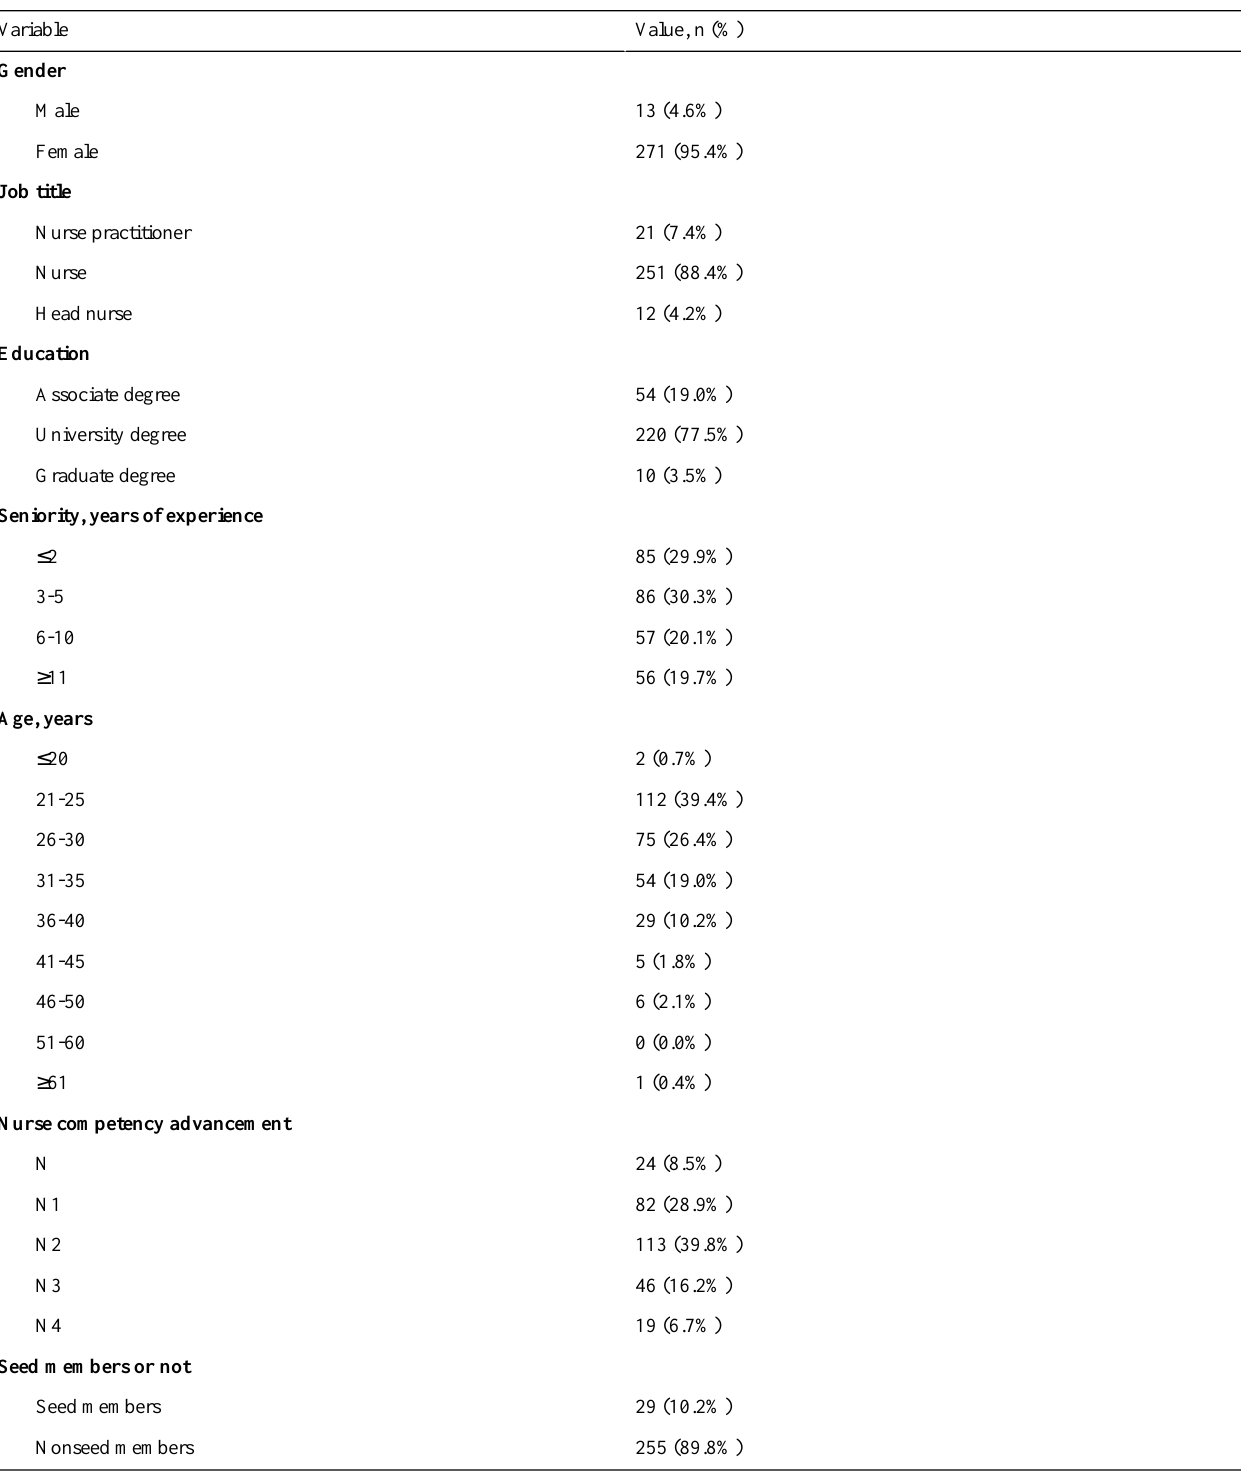
Table 1. Characteristics of the participating nursing staff